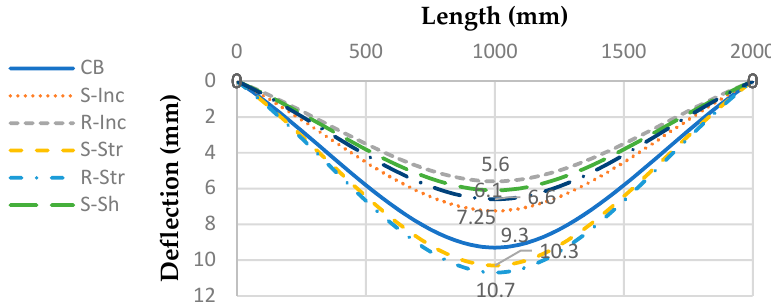
Figure 8. Deflection along the beams’ length.